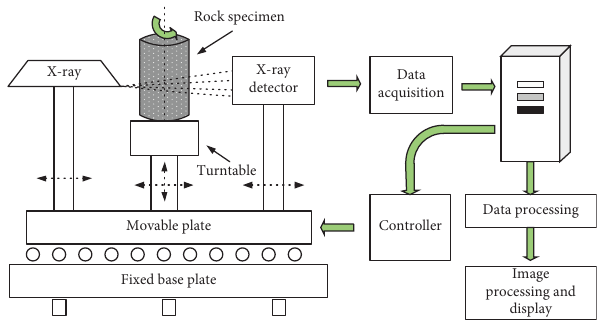
Figure 1: Schematic diagram of the μ 225Kv microfocus CT system for scanning and data processing.